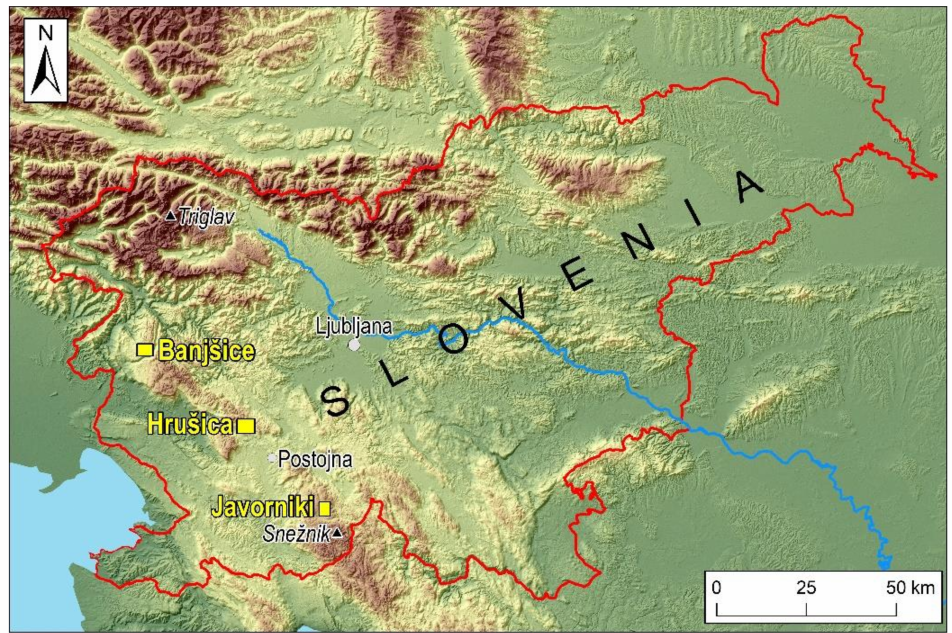
Figure 1. Location of the study areas (Javorniki, Hrušica, and Banjšice) in